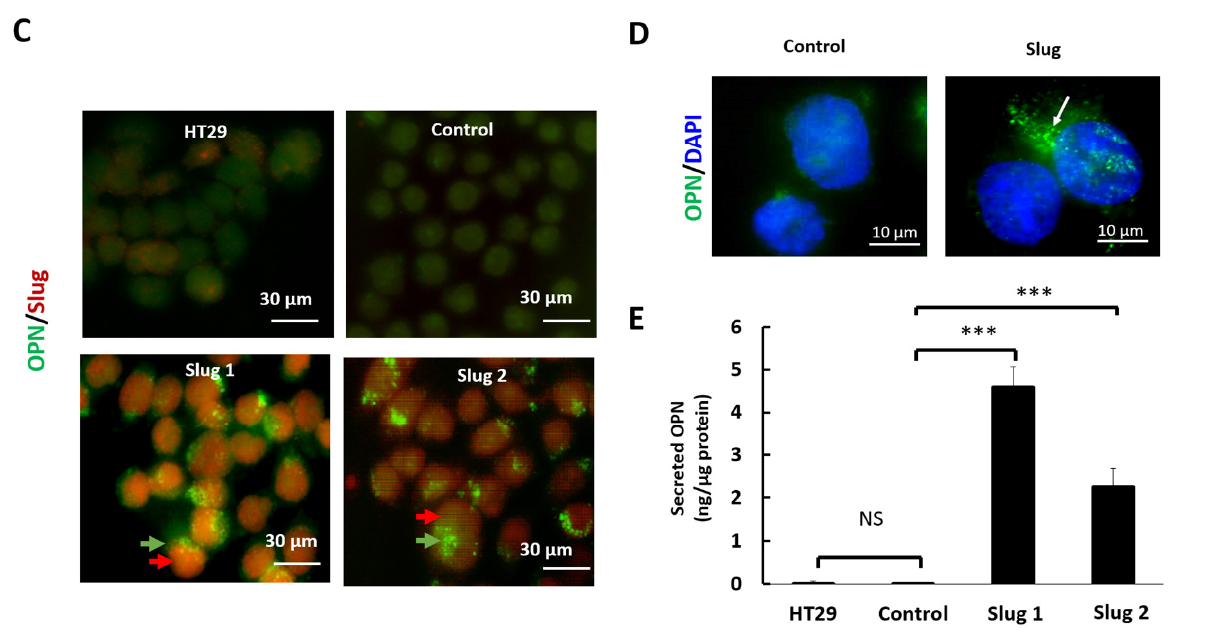
Figure 3. Slug/SNAI2 promotes the expression and secretion of OPN. HT-29 cells were stably transfected with a plasmid coding for Slug or with an empty expression vector (control). ( A ) The expression of Slug and OPN mRNA was determined by qRT-PCR, and the results were normalized to HT-29. ( B ) The expression of Slug and osteopontin protein was determined by Western blot analysis with β -actin as loading control. ( C ) Cells were stained with OPN-directed (green) and Slug-directed (red) antibodies, and the localization of the corresponding proteins was detected by immunofluorescence. Magnification × 100. Punctiform labeling of OPN is indicated with green arrows. ( D ) Cellular sub-localization of osteopontin in parental and Slug tranfectants as determined by immunofluorescence staining of osteopontin (green). Nuclei were stained with DAPI (blue). Punctiform labeling of OPN is indicated with white arrows. ( E ) Conditioned media were collected, and the amounts of secreted osteopontin were quantified by ELISA. Data were analyzed by the Student’s two-tailed t -test and considered significant when p was less than 0.05. Symbols: *** p < 0.001, NS, not significant.